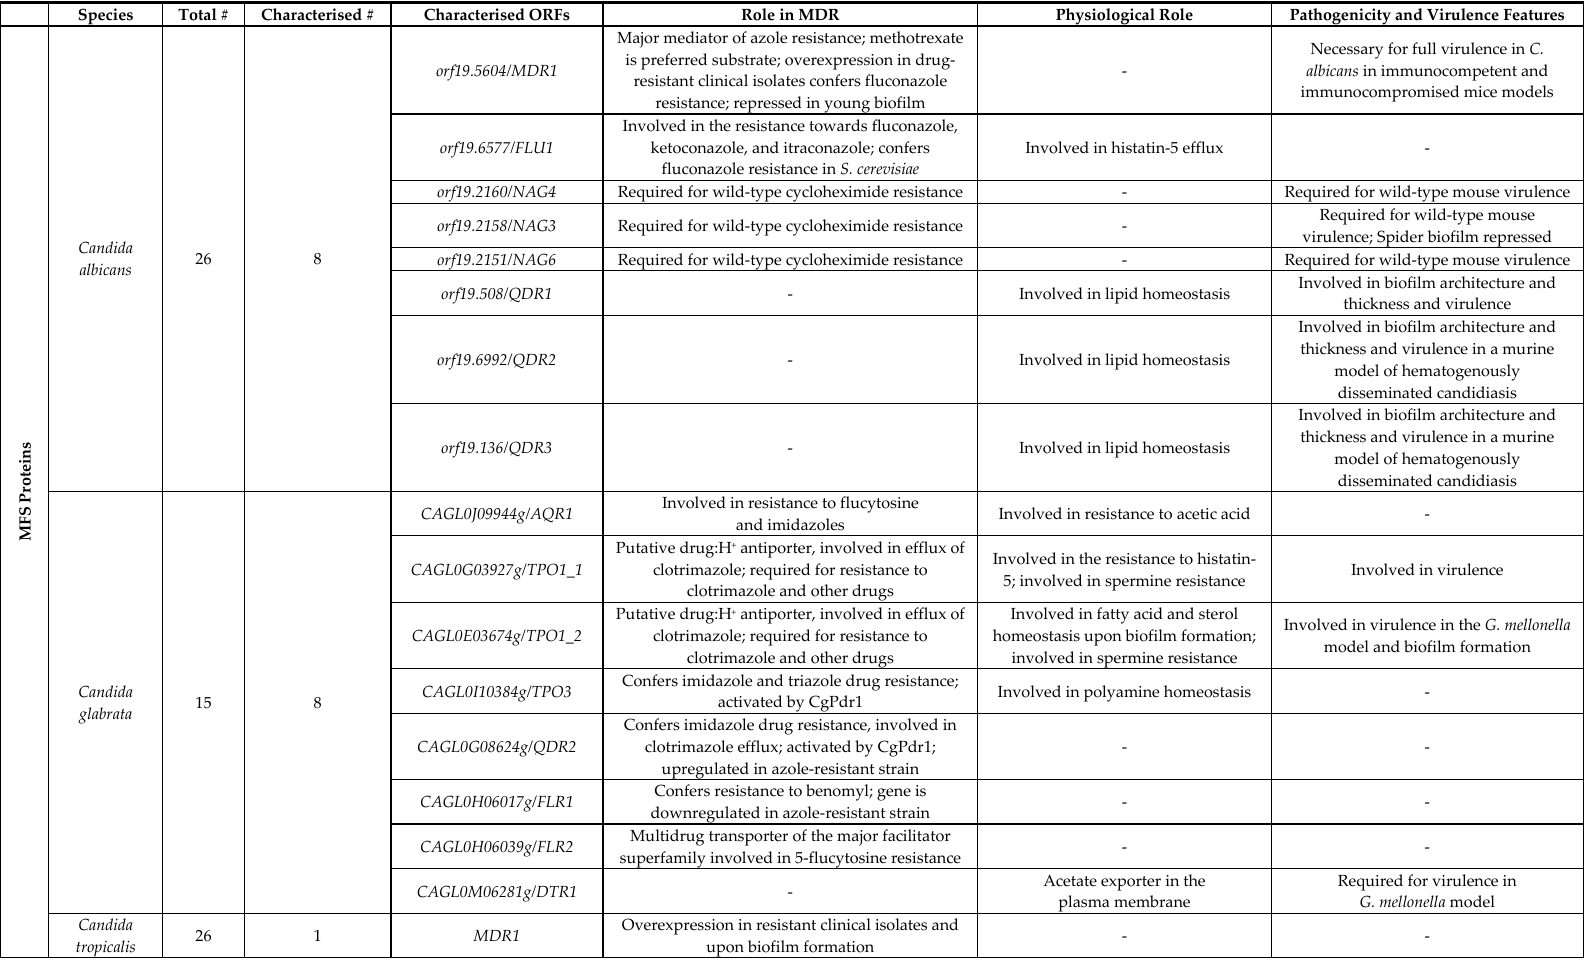
Table 2. MFS transporters of Candida , Aspergillus , and Cryptococcus species, focusing their roles in MDR and physiological functions, as well as their pathogenicity and virulence features.